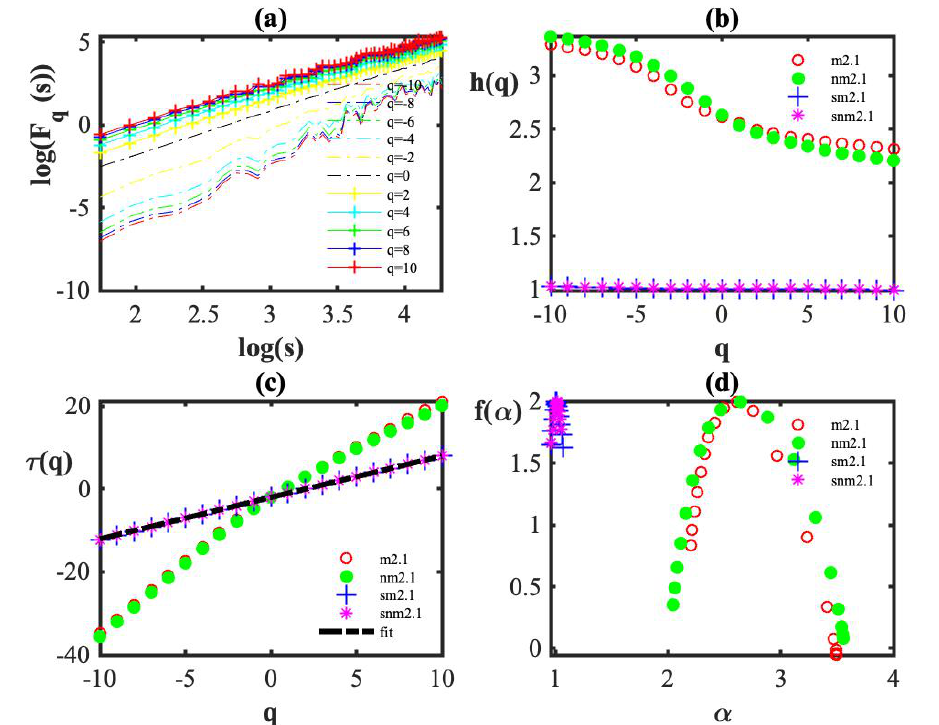
Figure A1. ( a ) log ( F q ( s x , s y )) versus log ( s ) for a randomly chosen sample, as can be seen in Figure C1. (a) log ( F q ( s x , s y )) versus log ( s ) for a randomly chosen sample, see equation (A.4). (b) The Equation (A4). ( b ) The scaling exponent, h ( q ) , of F q ( s x , s y ) , Equation (A4), versus the order of the scaling exponent, h ( q ) , of F q ( s x , s y ) , equation (A.4), versus the order of the moment q is depicted. (c) moment q is depicted. ( c ) The multifractal scaling exponent τ ( q ) as it is obtained via Equation (A5) versus the order of the moment, q , is illustrated. ( d ) The multifractal spectrum, f ( α ) versus α , as it